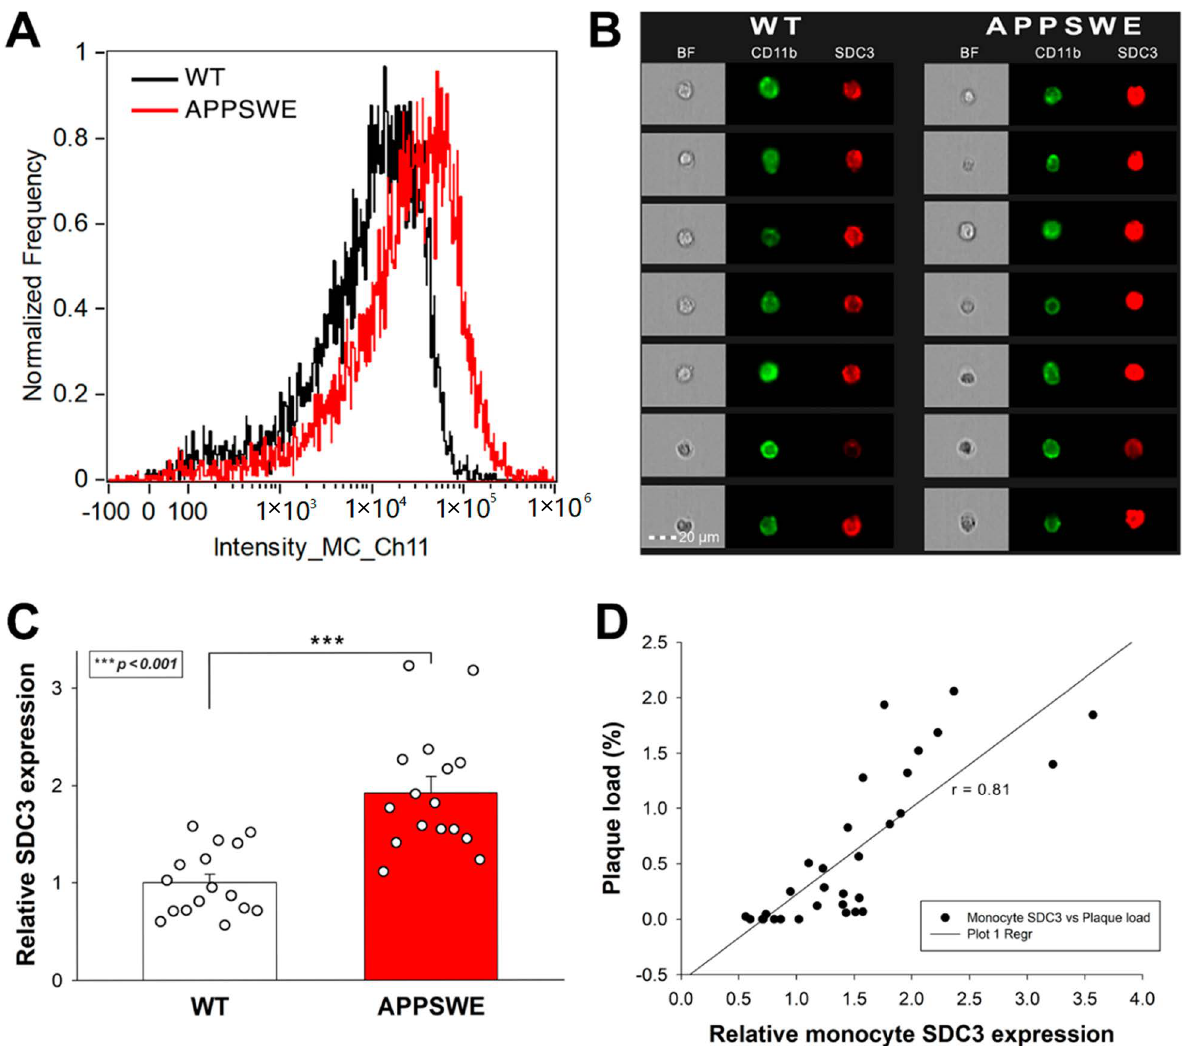
Figure 6. Monocytes isolated from APPSWE-Tau mice exhibits increased SDC3 expression. Isolated monocytes were treated with CD11b and SDC3 antibodies, and SDC3 expression of CD11b positive cells was analyzed with imaging flow cytometry. ( A ) Representative histogram showing the SDC3 expression of monocytes isolated from APPSWE-Tau and WT mice. ( B ) BF and fluorescent cellular images of CD11b and SDC3 antibody-treated monocytes, isolated from APPSWE-Tau and WT mice. Each group contained eight animals. SDC3 expression of each sample was measured twice. ( C ) De- tected fluorescence intensities were normalized to WT. The bars represent the mean + SEM. Statis- tical significance vs. WT was assessed with ANOVA. *** p < 0.001. ( D ) Linear regression between the SDC3 expression of monocytes and A β plaque loads.